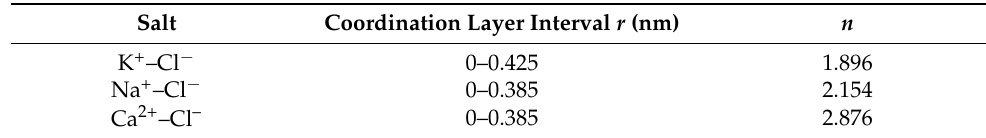
Table 3. Coordination numbers of the cations in the first coordination